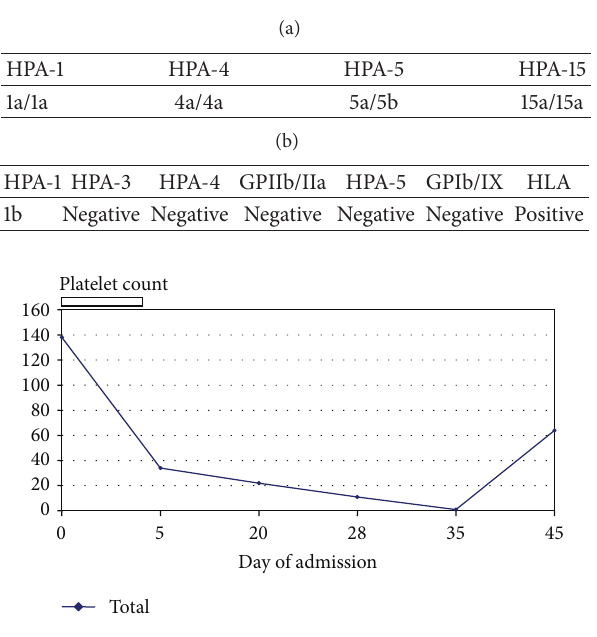
Figure 1: Chart showing trend of platelet